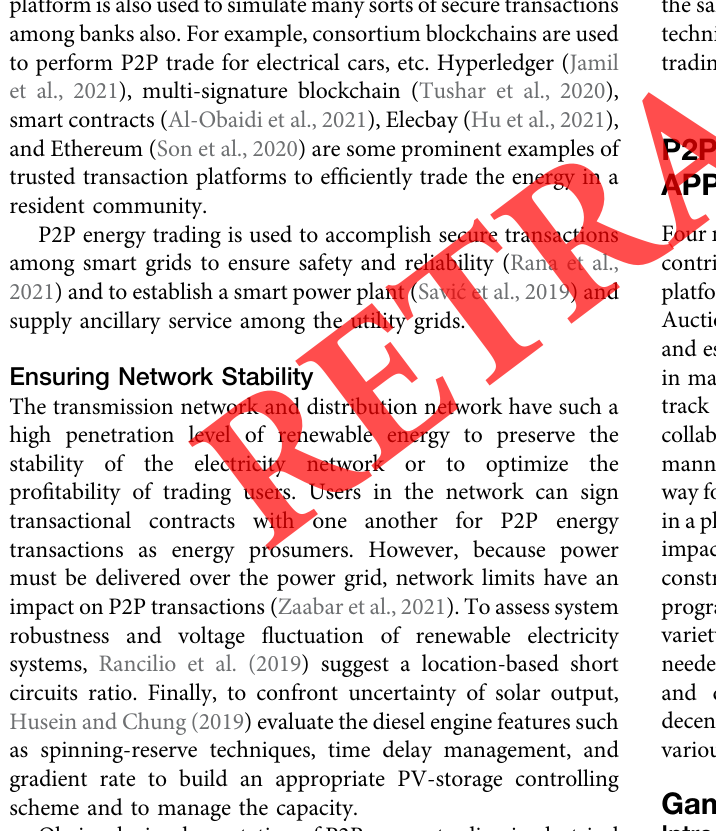
FIGURE 5 | Physical layer challenges in a peer-to-peer